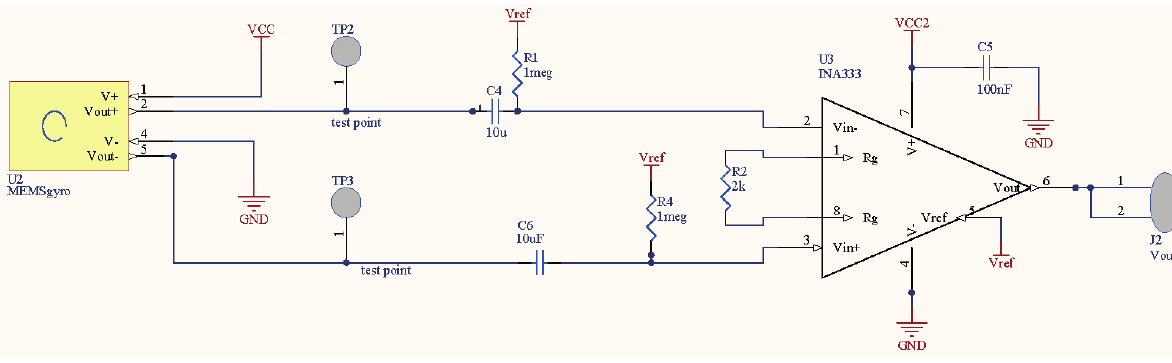
Figure 6. Schematic design of the PCB test board for testing the proposed sensor.